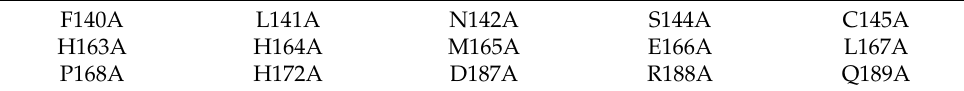
Table 1. Artificial mutants used for virtual alanine scan.